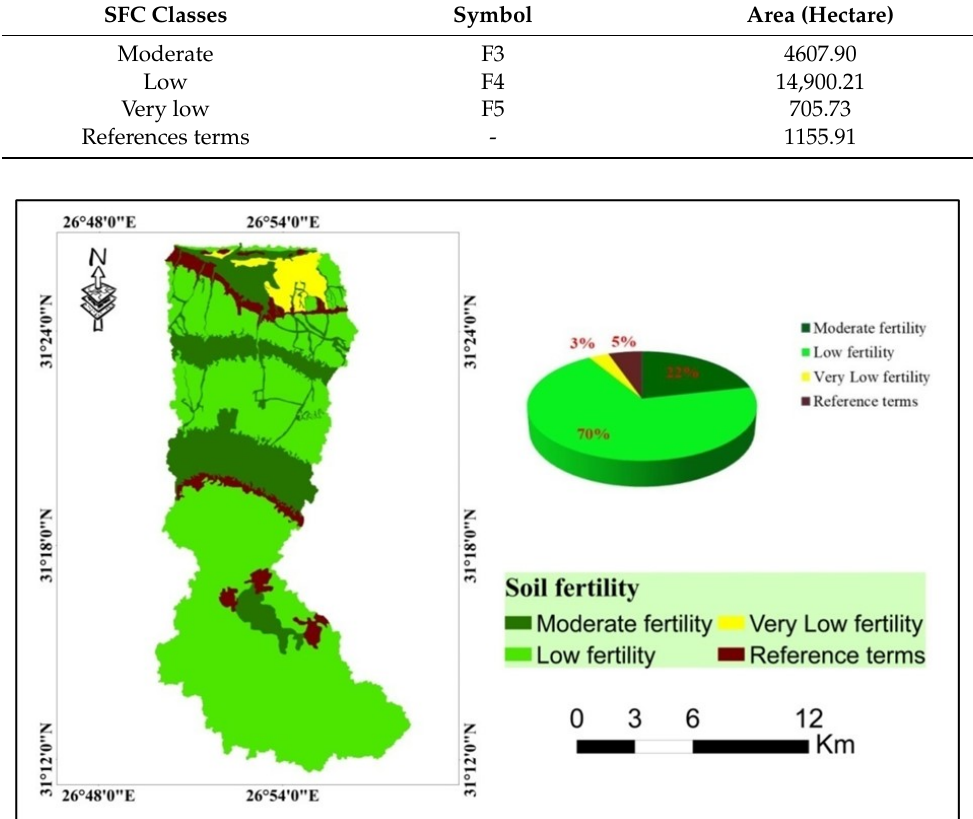
Figure 12. SFC areas of the study